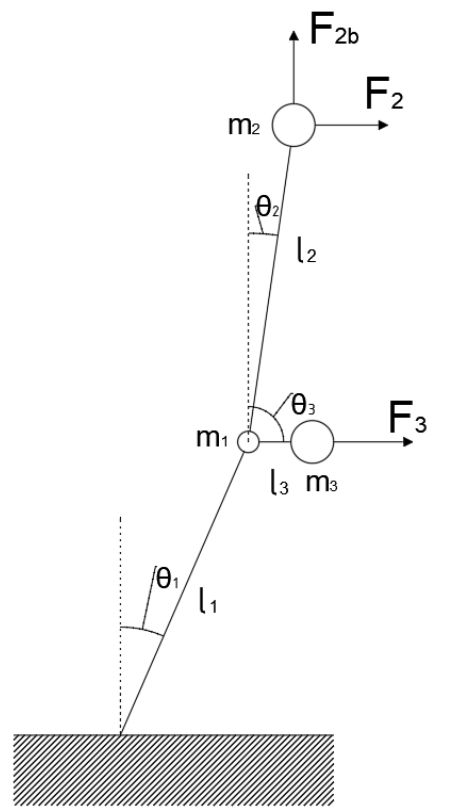
Figure 3. Multi-pendulum system with a finite number of rods and